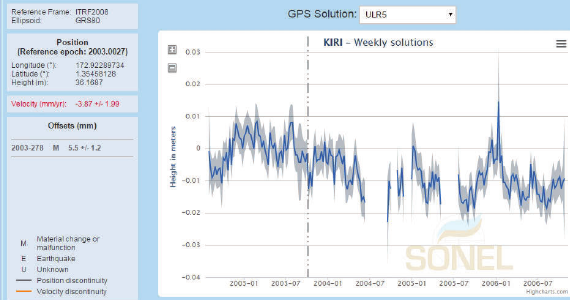
Fig. 9: Vertical velocity of the KIRI GPS dome according to SONEL (image from